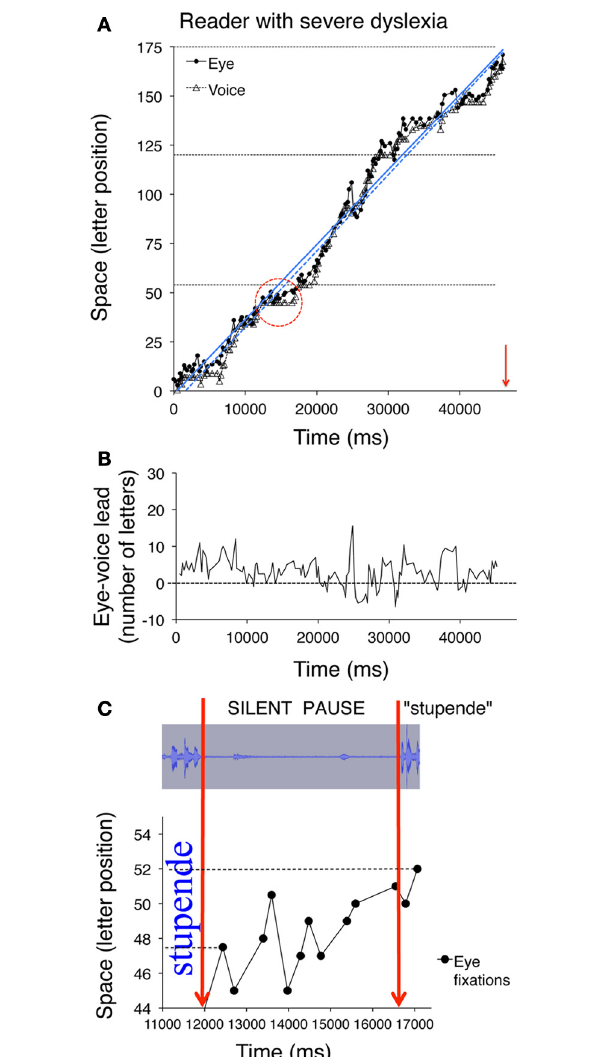
FIGURE 6 | Eye and voice data are presented for a child with severe dyslexia. Similar to Figures 5A,B , the pairs of fixated grapheme/uttered phoneme positions are plotted as a function of time in panel (A) . Note that the scale on the abscissa of panel (A) is twice that of Figures 5A,B , therefore the slope indicates a much slower reading rate than that of the child with mild dyslexia represented in Figure 5B . In panel (B) (as in Figures 5C,D ) the eye-voice lead is represented as a function of time as letter difference between pairs of simultaneous grapheme and phoneme positions. The (C) inset (obtained by zooming on the marked area of plot A ) represents a long silent pause made by the child, during which eye fixation scanning is characterized by eight rightward saccades and three regressions in the word “stupende” (English translation: “wonderful”) before pronouncing it. The top part of the inset represents the spectral image of the audiotrackcorrespondingtothetimeintervalrepresentedinthebottompart, which corresponds to the pattern of fixations made on the word. Note that both the second and the fifth fixations (at letter position number 45) follow a regressive eye movement that brings the gaze to the inter-word blank